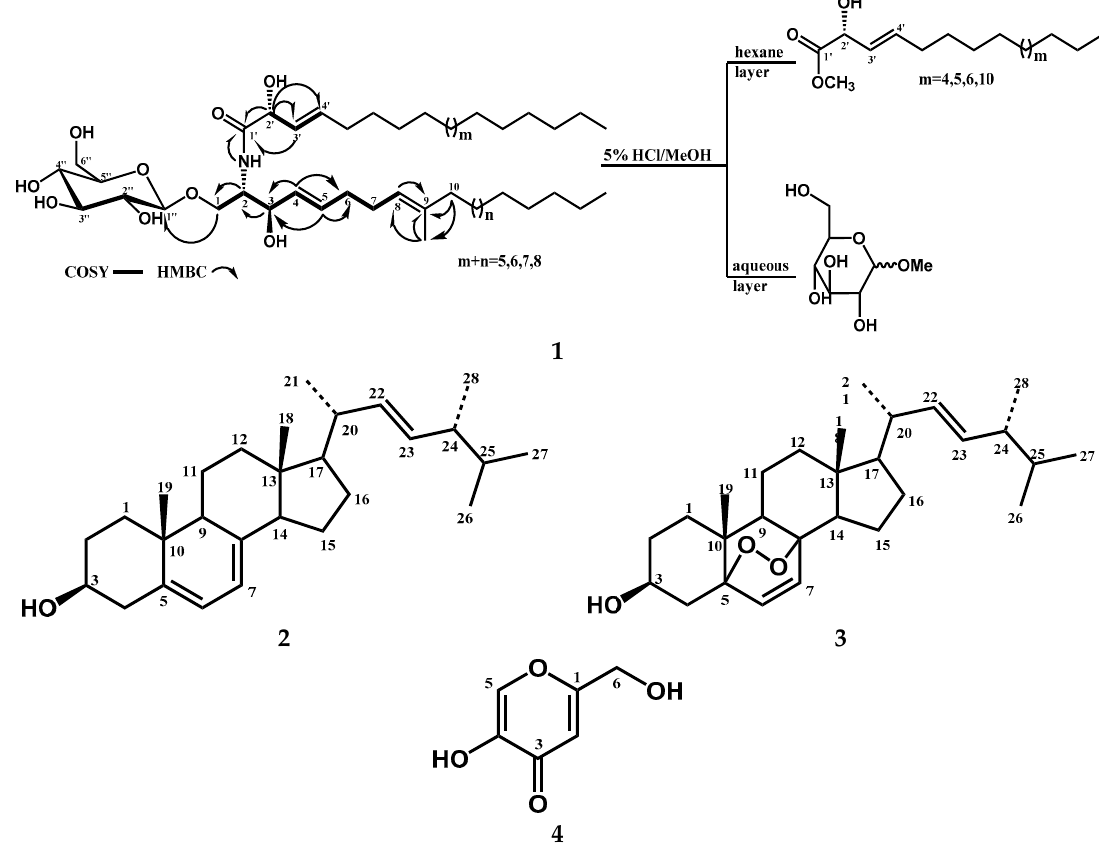
Figure 1. Structures of isolated compounds 1 – 4 . Table 1. NMR (Nuclear Magnetic Resonance) data of 1 (pyridine- d 5 ).